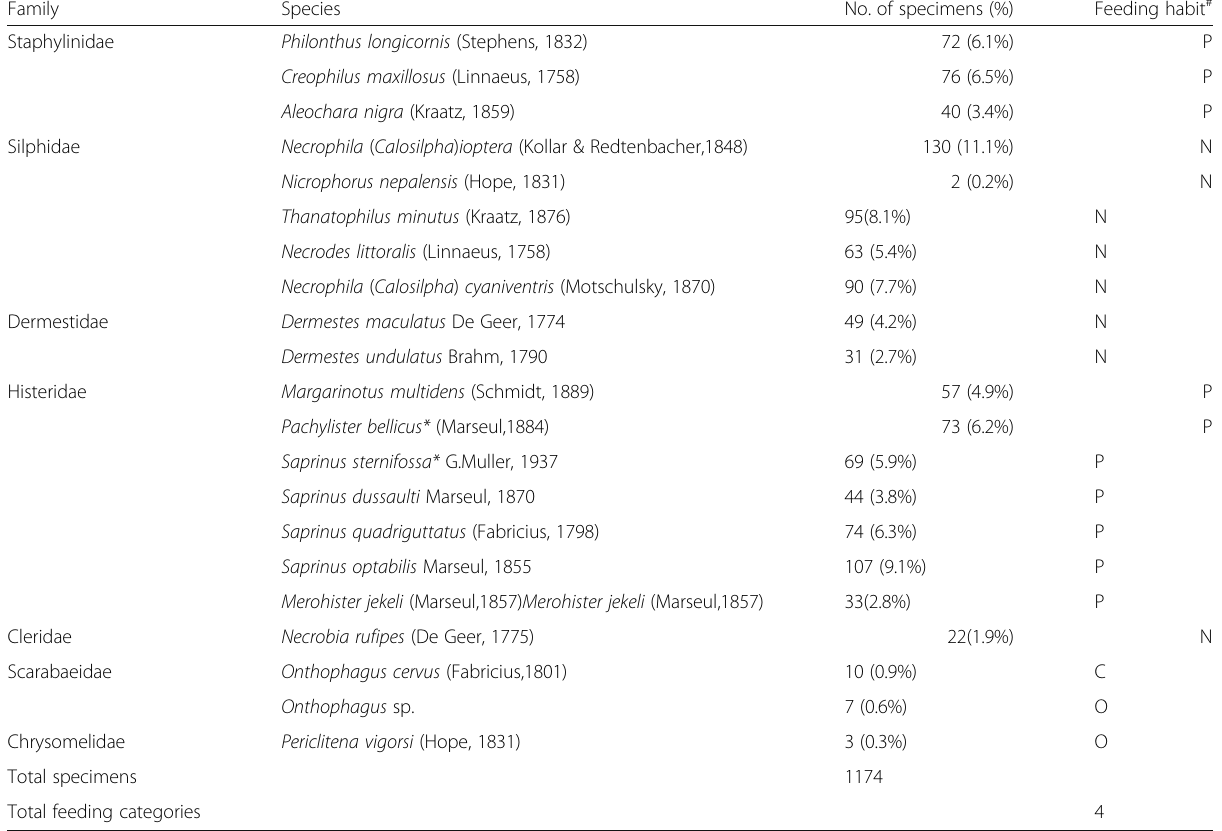
Table 1 List of all beetle species and their number found during this study